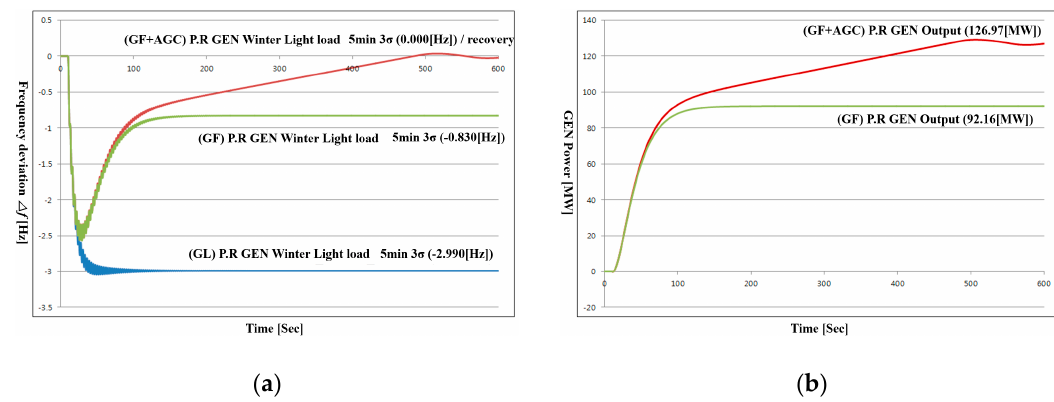
Figure 30. Output of system with PR generator: ( a ) Frequency characteristics; ( b ) PR generator power output.